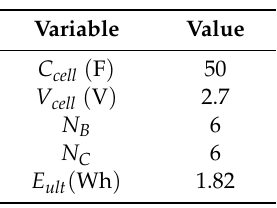
Table 8. Estimated energy capacity of the